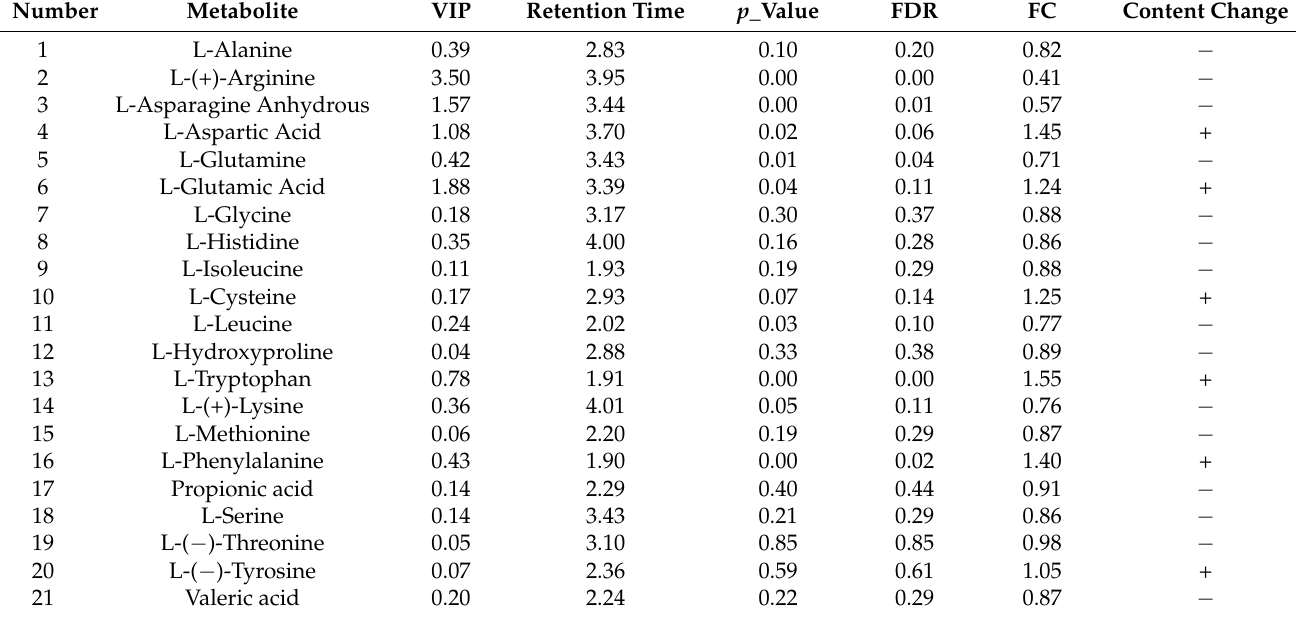
Table 4. Statistical analysis results of targeted amino acid metabolites in Z-2-GS-2 vs.